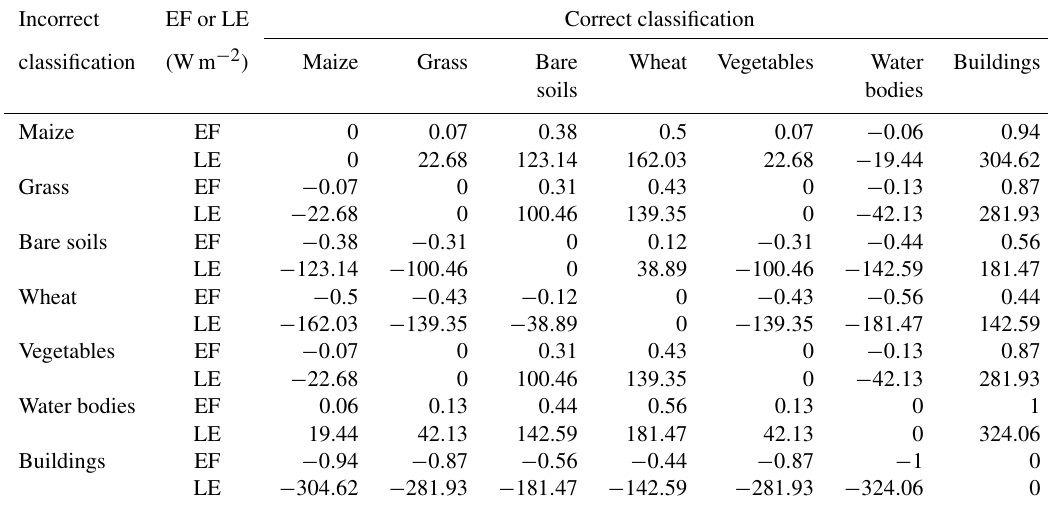
Table 4. Differences in EF and LE caused by incorrect classification. The “ + ” and “ − ” symbols indicate overestimation and underestimation, respectively. The average AE was 324.05Wm − 2 over the entire study